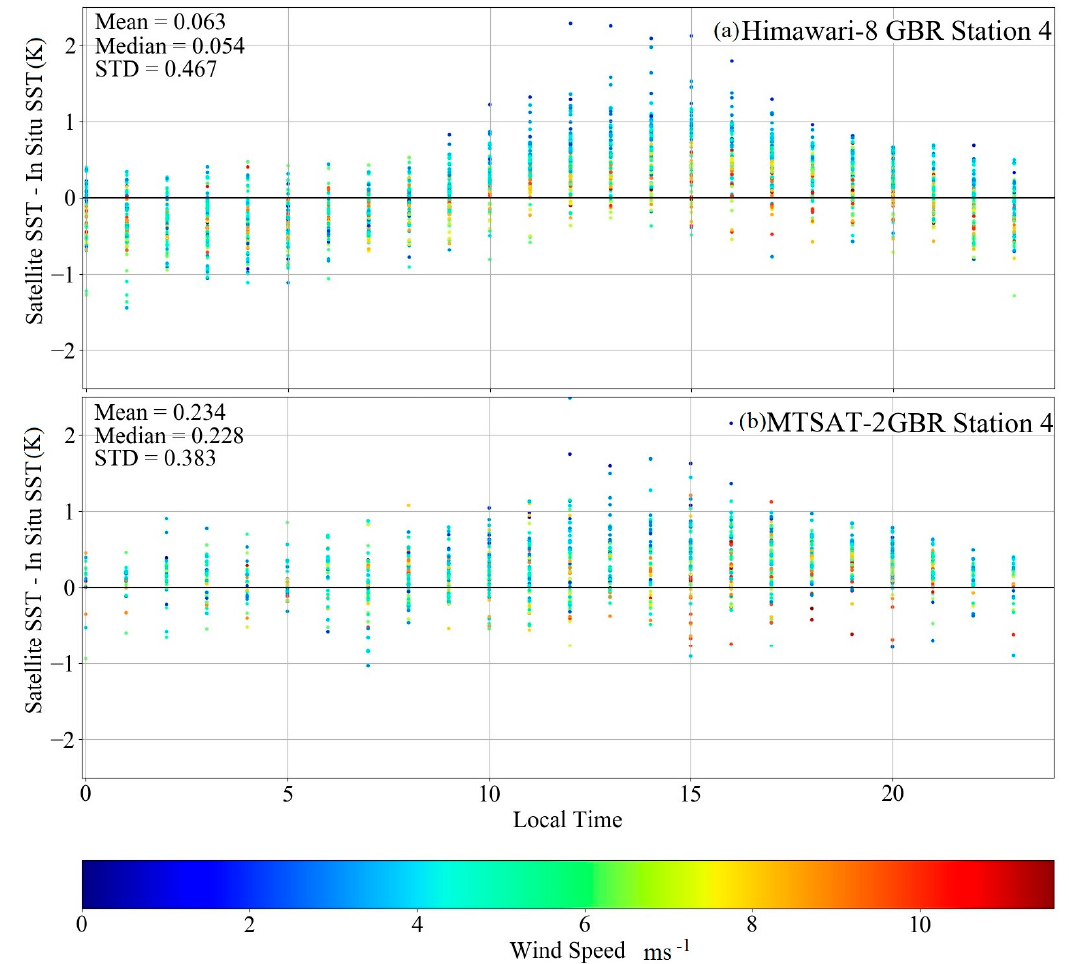
Figure 10. As Figure 9 but for GBR Station 4 at 18.49°S, 146.87°E with in situ temperatures measured at a depth of 1.9 m.